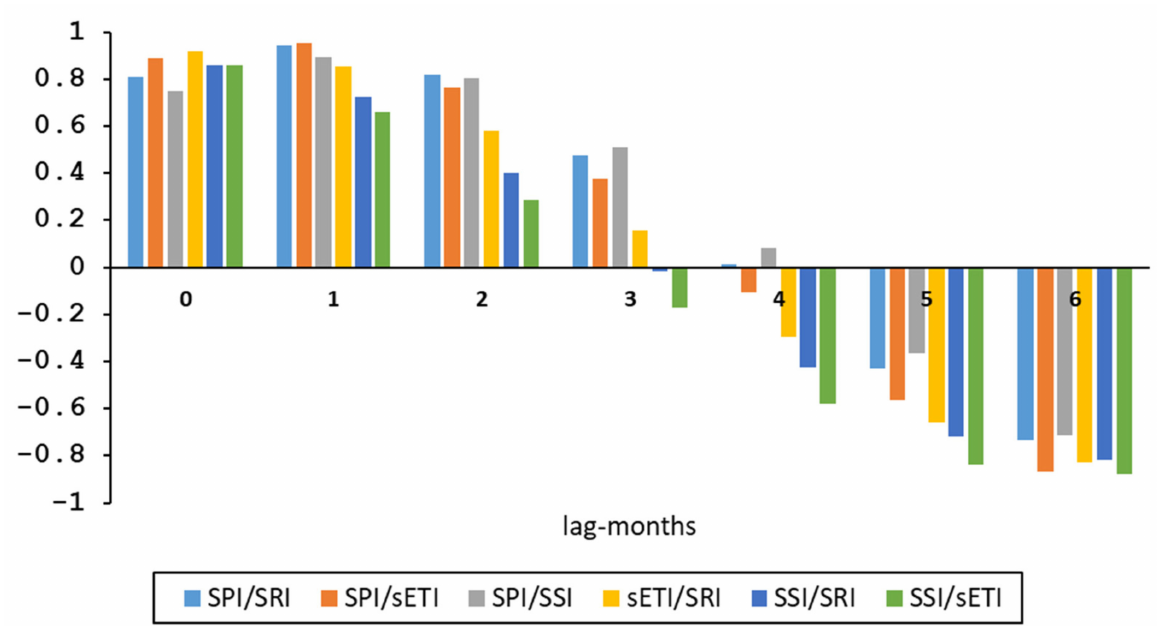
Figure 15. Correlation results among indices of 6-month accumulation period with a time lag up to 6